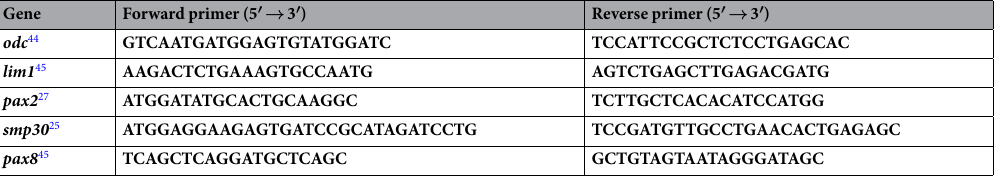
Table 1. Primers used for RT-PCR.